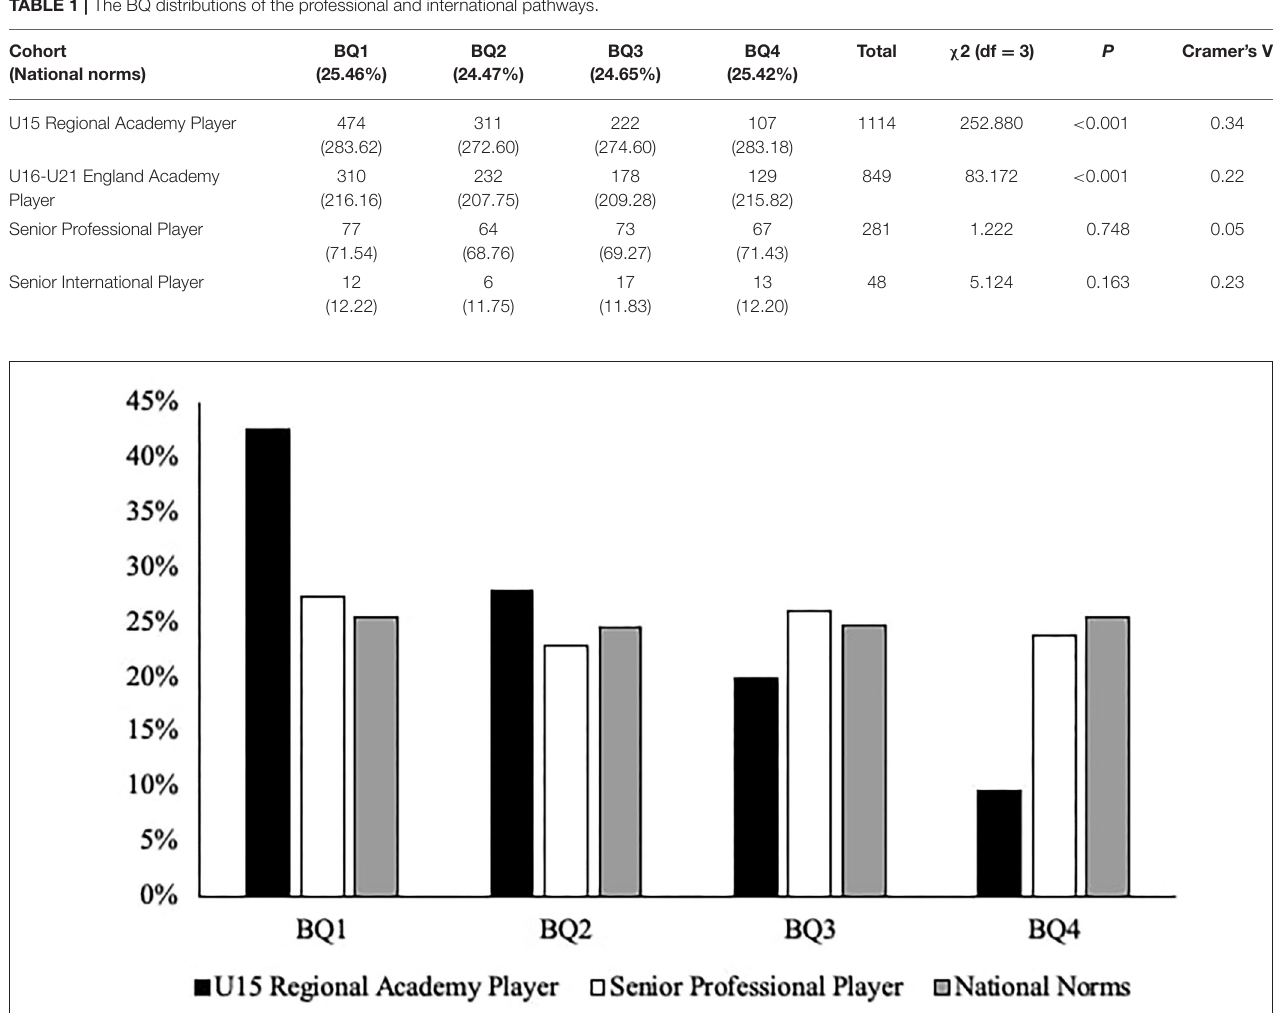
FIGURE 1 | The BQ distribution percentages of the professional